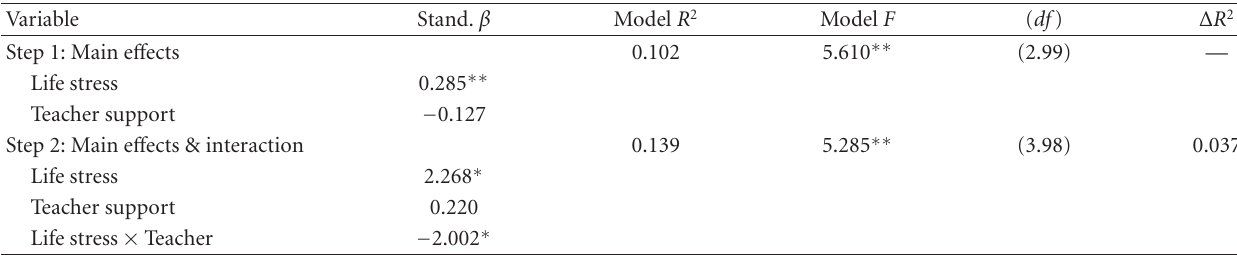
Table 1: Hierarchical regression—externalizing problems (BASC) as criterion.